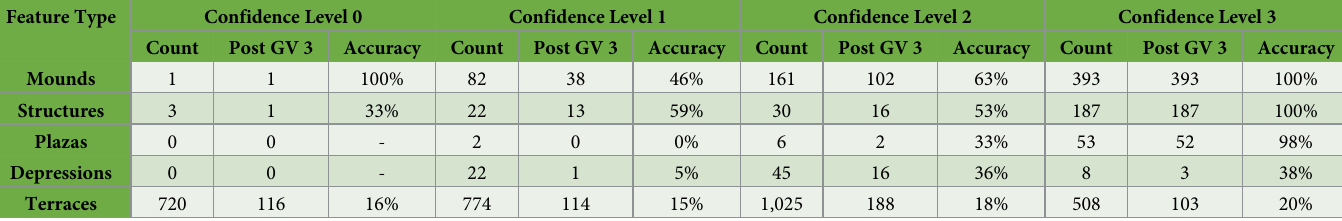
Table 2. Feature accuracy based on pre- and post-ground verification (GV) assessment by feature